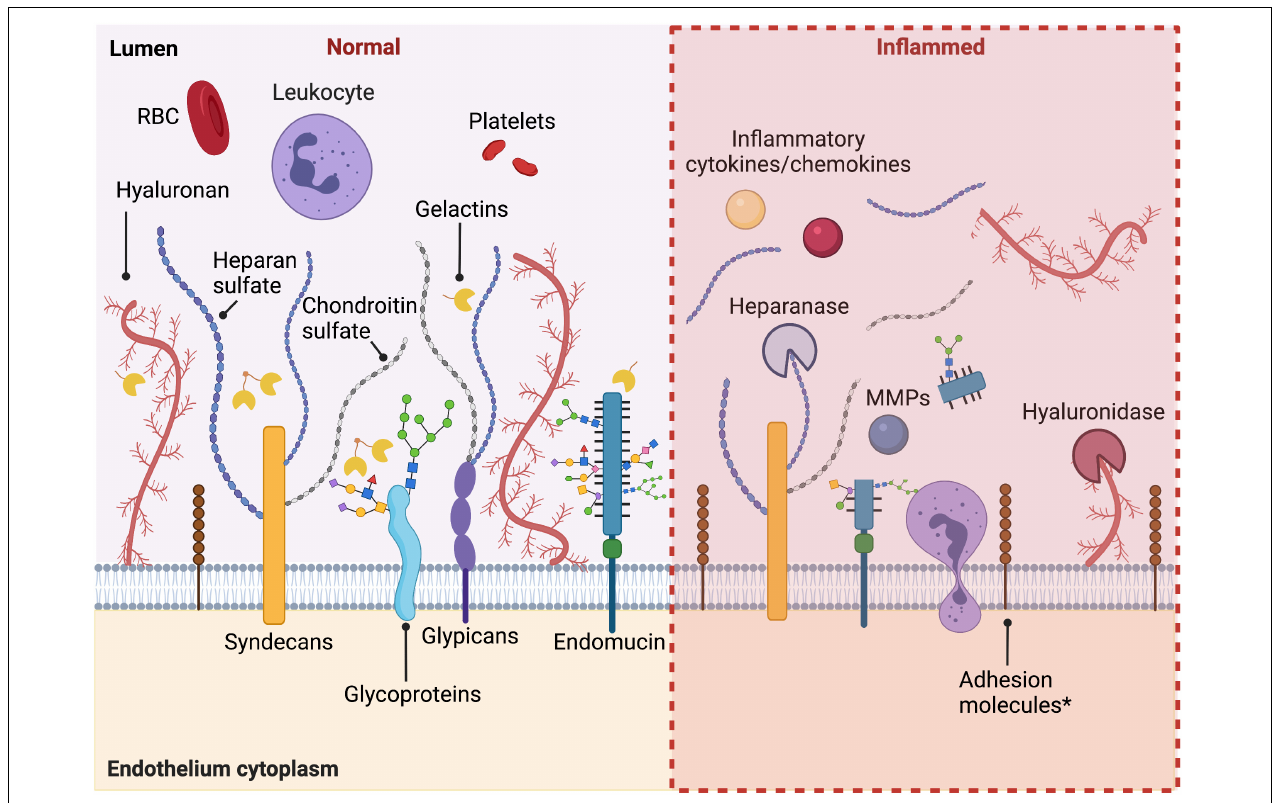
FIGURE 1 | Summary of the modulation of glycocalyx under activated conditions. Under healthy conditions, intact endothelial glycocalyx maintains endothelium homeostasis, regulating permeability, and plays an anti-inflammation and anti-thrombosis role. When activated in pathological conditions, during inflammation, diabetes, and other pathological conditions, there is increased shedding of the glycocalyx. An increased expression of adhesion molecules under inflammatory conditions is also observed. Figure was created with BioRender.com.